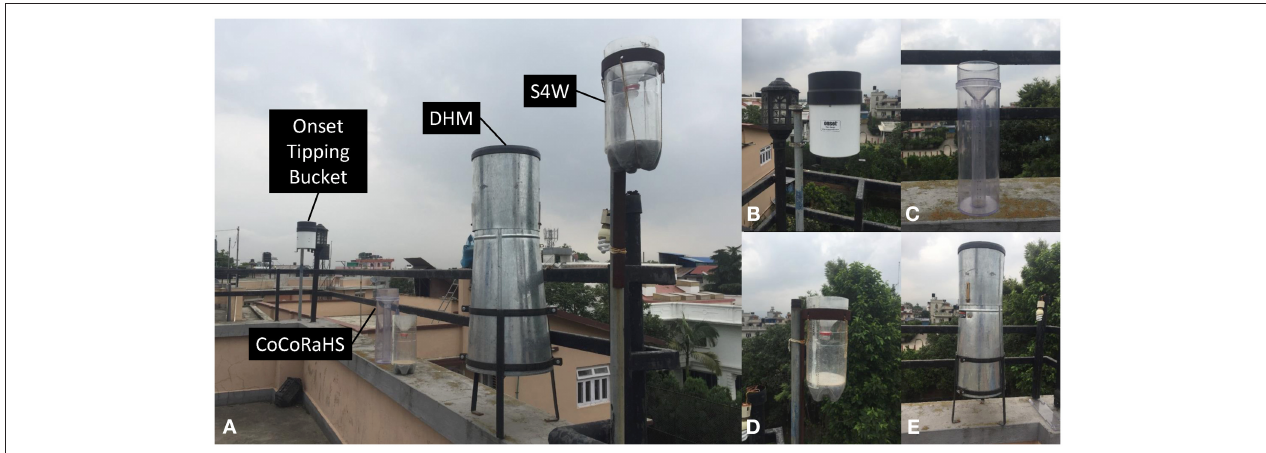
FIGURE 4 | Comparison between (A) four different gauges including: (B) Onset Computer Corporation Hobo tipping bucket, (C) Community Collaborative Rain, Hail, and Snow Network (CoCoRaHS) standard 102mm (4-inch) diameter gauge, (D) S4W gauge, and (E) the Nepali Department of Hydrology and Meteorology (DHM) standard 203mm (8-inch) diameter gauge (similar to a US National Weather Service 203mm (8-inch)